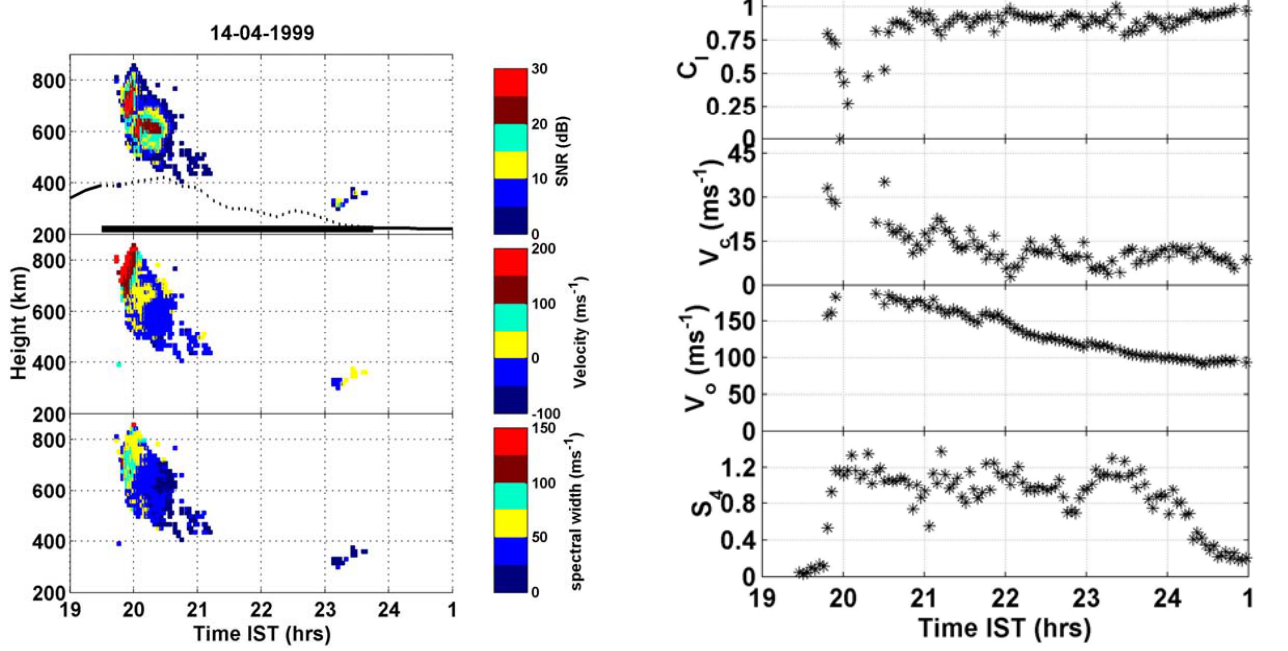
Fig. 2. (a) Same as Fig. 1a but for 14 April 1999. (b) Same as Fig. 1b but for 14 April 1999.